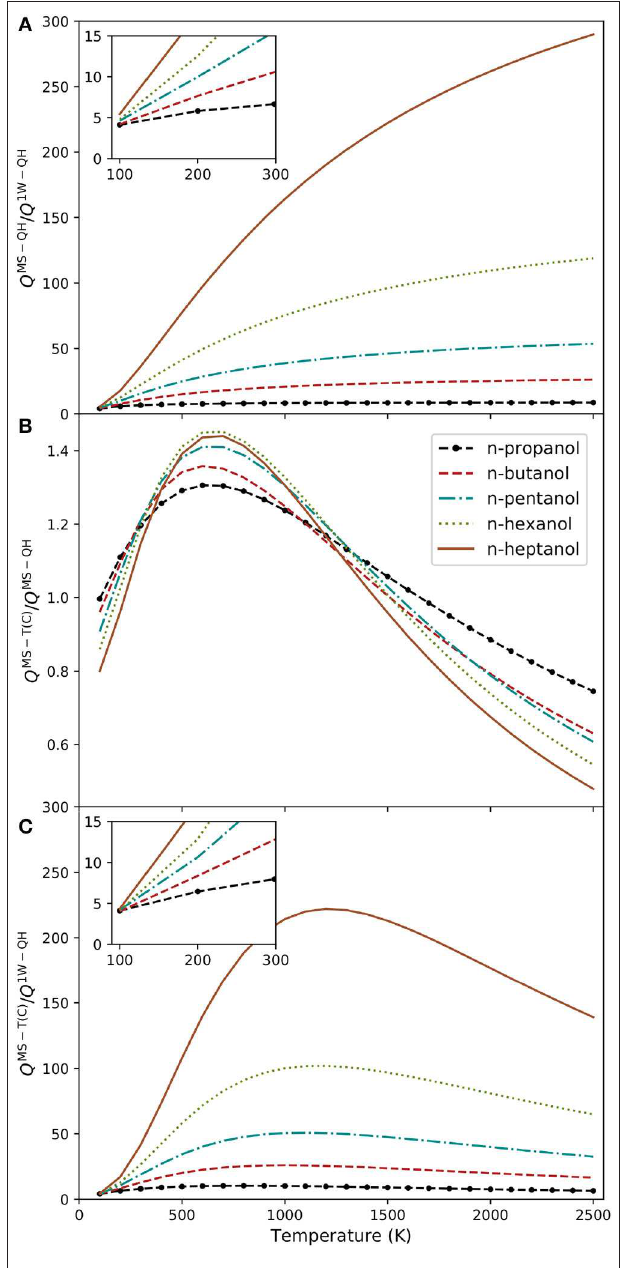
FIGURE 4 | Alcohols partition function ratios plotted at several temperatures: (A) Q MS − QH / Q 1W − QH ; (B) Q MS − T(C) / Q MS − QH ; and (C) Q MS − T(C) / Q 1W − QH .